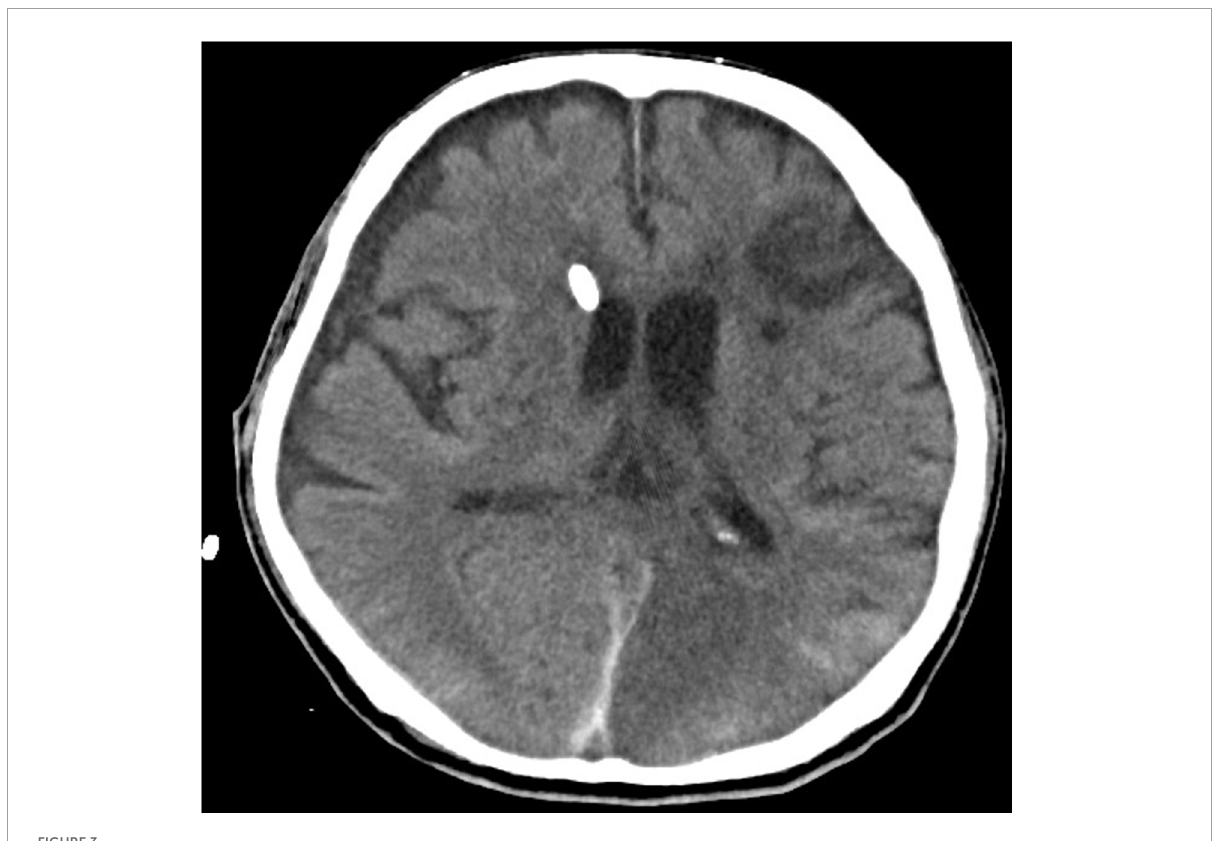
FIGURE3 Computed tomography brain with EVD traversing through the right lateral ventricle with reduction of hydrocephalus.